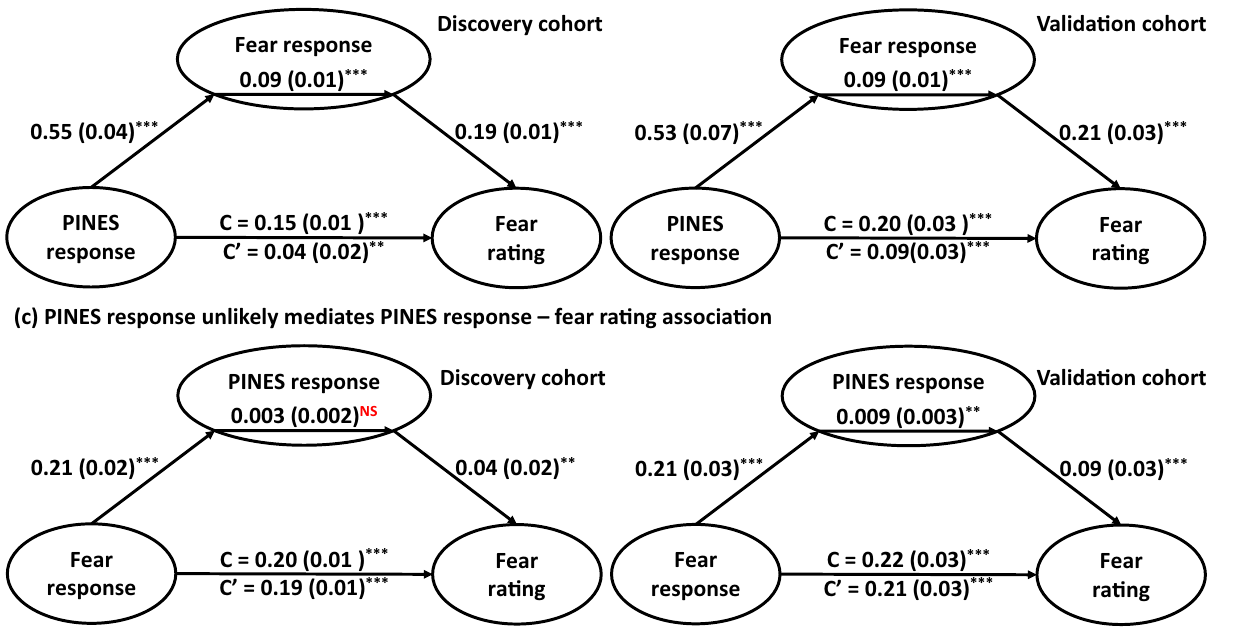
Table 2 Comparing prediction (correlation) of VIFS and PINES.